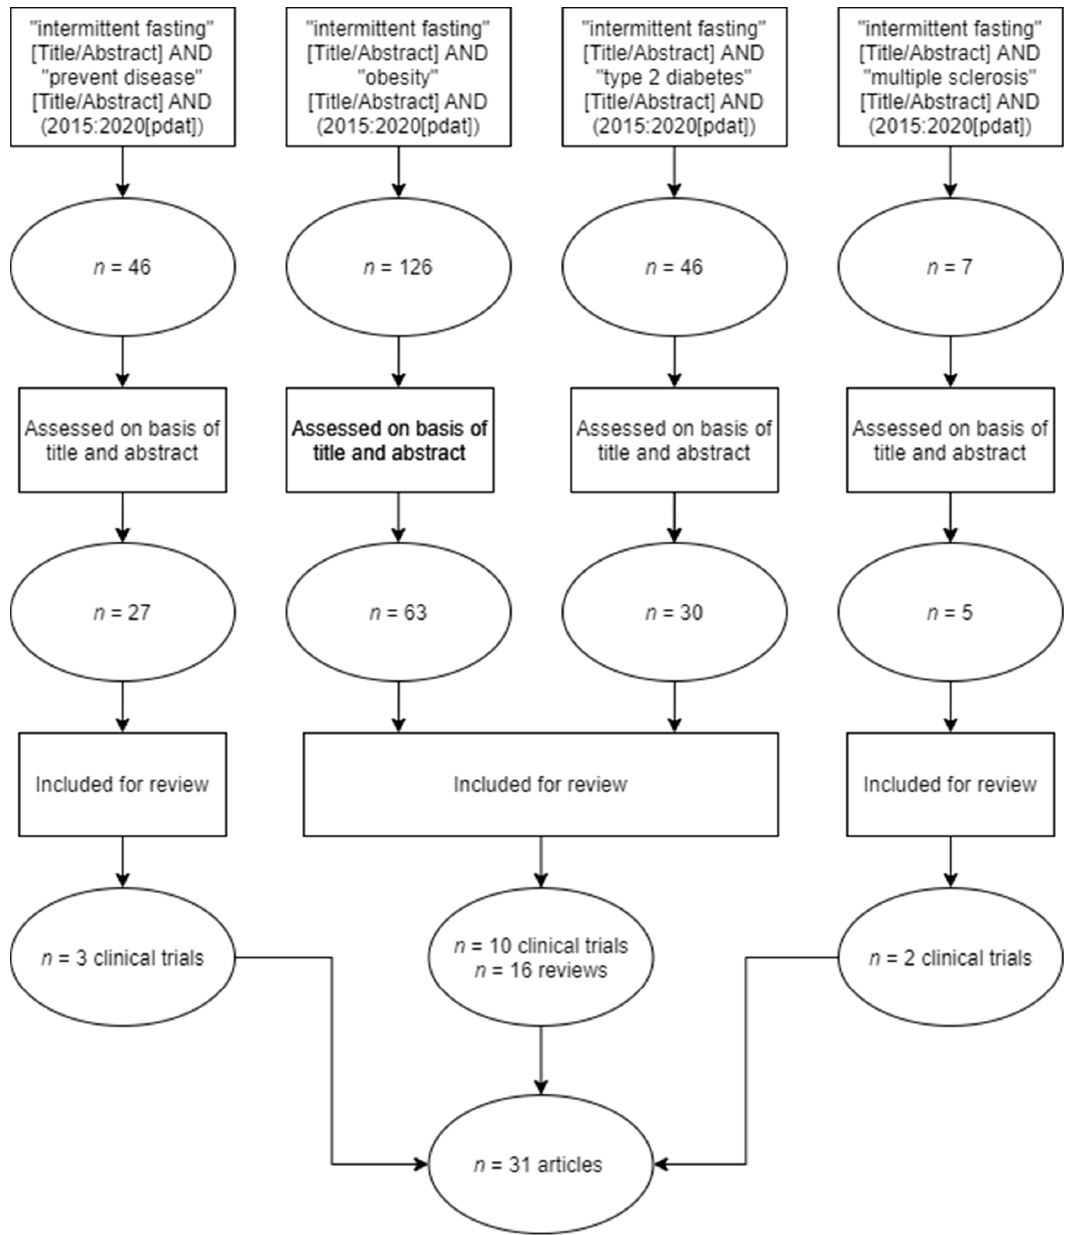
Figure 1. Flow chart of the selection process of articles for the bibliographic review on intermittent fasting and disease prevention.